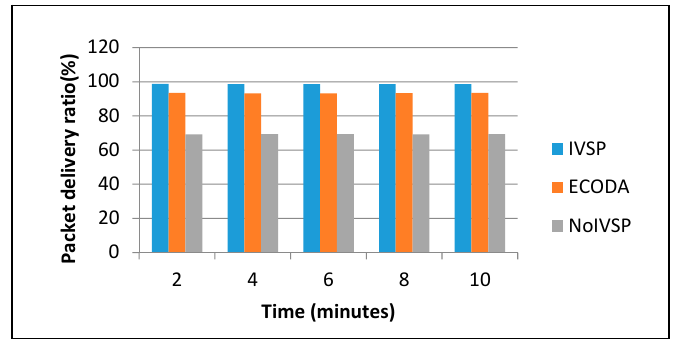
Figure 10. Packet Delivery ratio of I Frame packets.